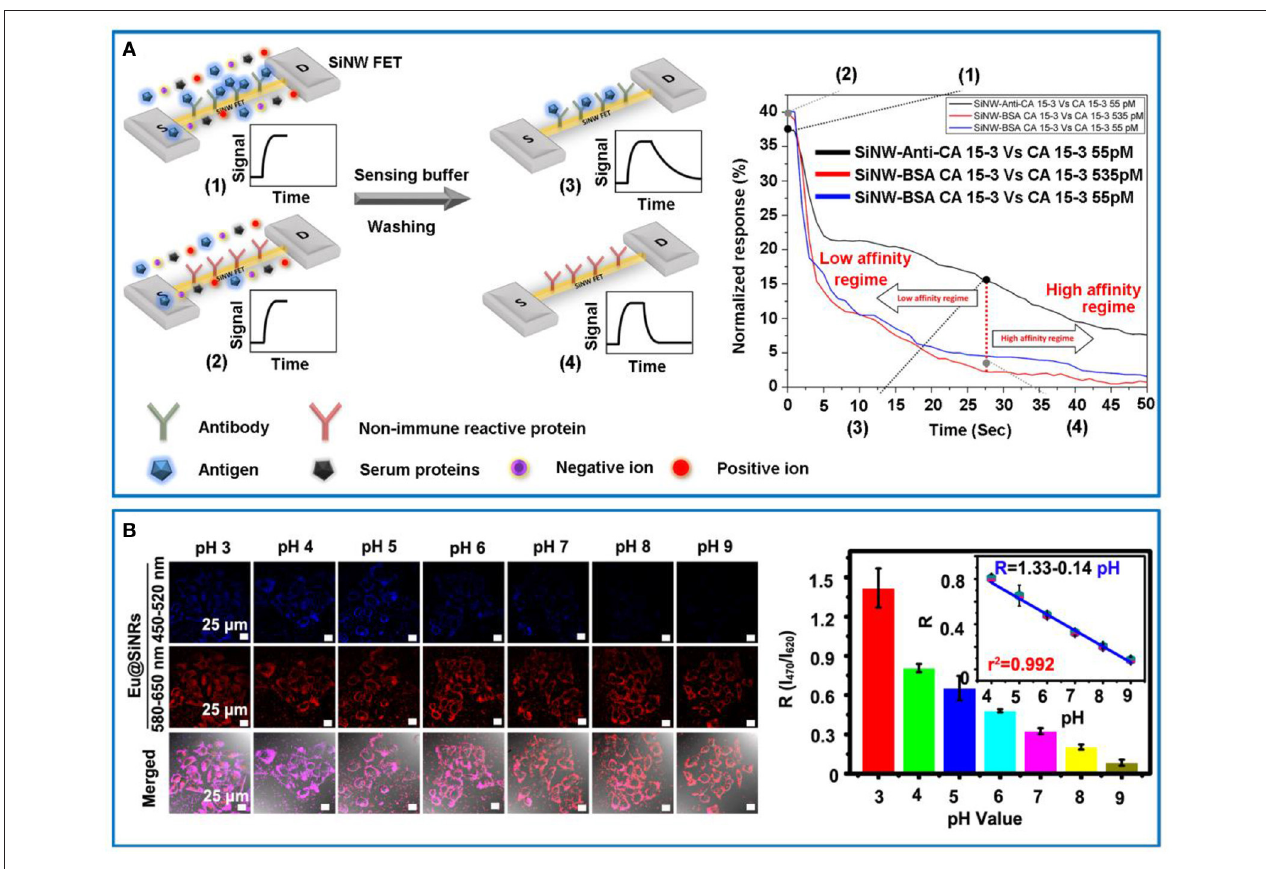
FIGURE 1 | (A) Schematically illustrating the workflow of antibody-conjugated SiNW-based FET sensor device (upper part, green receptor units) vs. non-immune reactive protein-conjugated control device (lower part, red receptor units) (left panel). Right panel: Specific (anti-CA 15-3) and non-specific protein (BSA CA-15-3) functionalized SiNW-based FET sensor devices for the detection of the CA 15-3 antigen. Reprinted with permission from Krivitsky et al. (2016). Copyright (2016) ACS Publications. (B) Eu@SiNRs for intracellular pH measurement. Confocal images of internalized Eu@SiNRs in MCF-7 cells with different cytoplasmic pH values (i.e., 3–9) (left panel). Scale bars = 25 µ m. Right panel: Corresponding histograms of the fluorescence intensity ratio ( R = I 470 / I 620 ) vs. pH values ranging from 3 to 9. Inset is the linear relationship between R and pH values (i.e., 4–9). Reprinted with permission from Chu et al. (2017). Copyright (2017) ACS